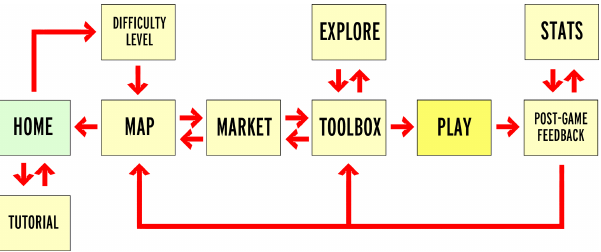
Figure 4. Flowchart showing the primary flow between the areas of this casual game.